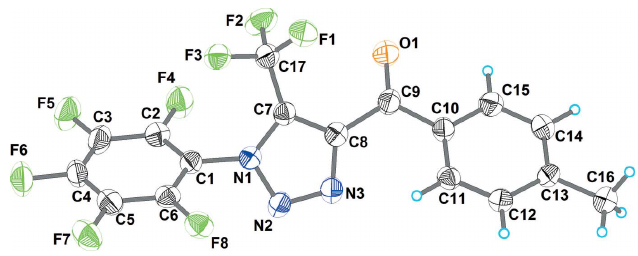
Figure 1 The molecular structure of (I) with displacement ellipsoids drawn at the 50% probability